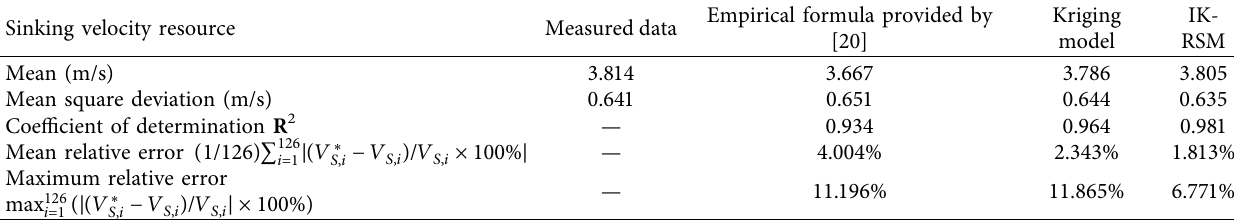
Table 5: Comparison of sinking velocity prediction results.